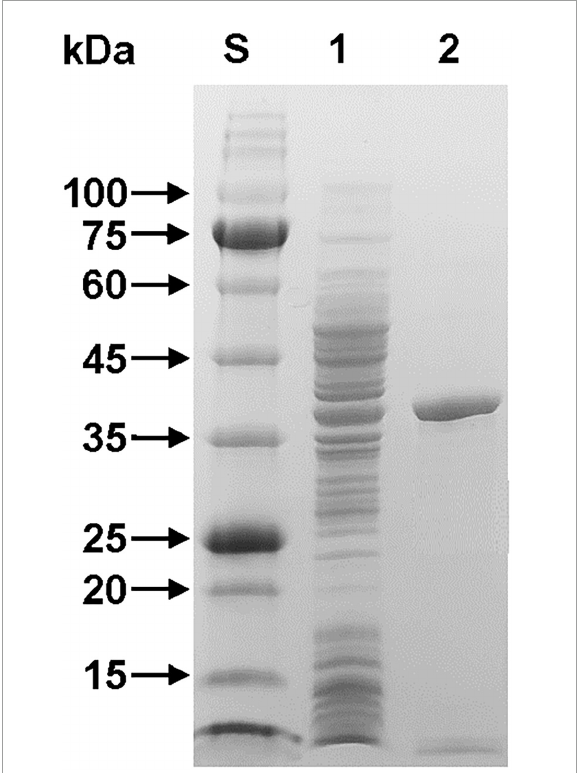
FIGURE3 SDS-PAGE of the purified rGluL after affinity chromatography on HisTrap HP. Lane S, standard marker proteins; lane 1, the soluble cell lysate of rGluL-expressing E. coli BL21 after IPTG induction; lane 2, purified rGluL.